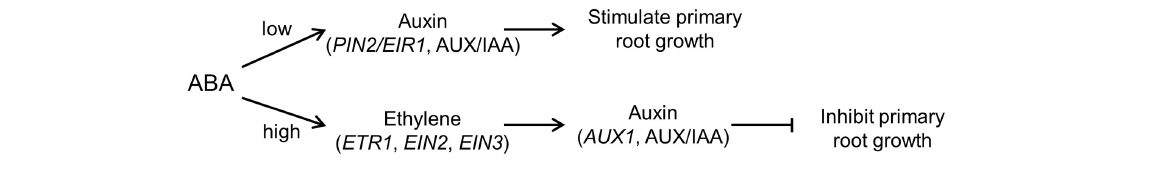
FIGURE 6 | A model for the involvement of ethylene and auxin in root growth responses to different ABA treatments. In the model, ABA regulates root growth through two distinct pathways: (1) an ethylene-independent stimulatory pathway that operates at low [ABA] and requires auxin signalling and auxin efflux through PIN2/EIR1; and (2) an ethylene-dependent inhibitory pathway that operates at high [ABA] and that also requires auxin signalling and auxin influx through AUX1. Ethylene regulates root growth through downstream auxin is based on the report that aux1-T mutant exhibited ACC-resistant root growth (R˚užiˇcka et al.,